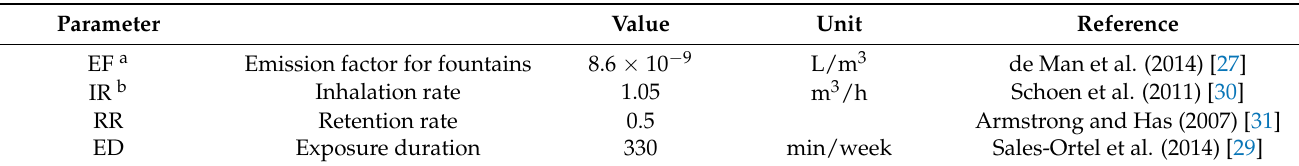
Table 1. QMRA parameters (mean values).